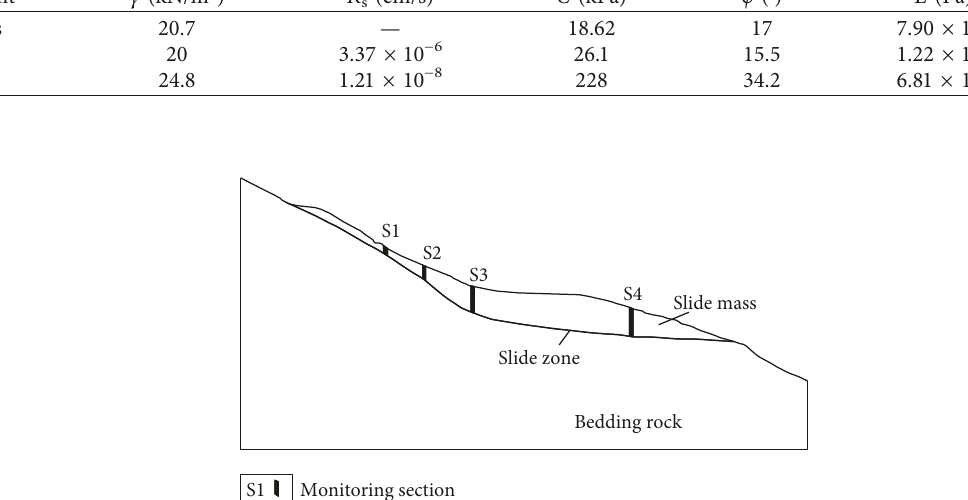
Figure 9: Monitored sections’ sketch of numerical